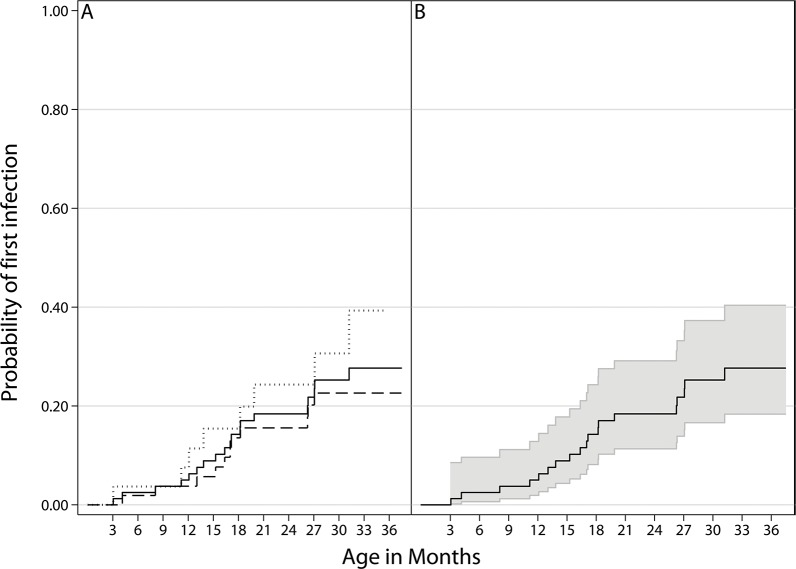
Probability of having the first infection with Saffold virus during follow-up.Probability is calculated as 1 minus the Kaplan-Meier estimate. 2A: All children (solid line), case children (dotted line) and control children (dashed line). 2B: All children (solid line) with 95% confidence interval bands. There is no statistical difference between the case and control children.